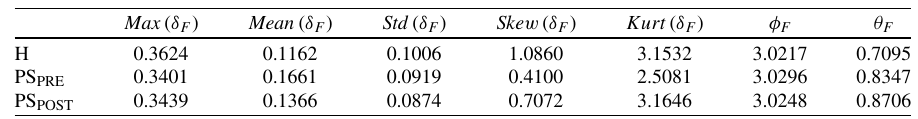
Fig. 15. Distance along straight line. Table 4 Parameters in Healthy (H), Post-stroke subjects before (PS PRE ) and after (PS POST ) the robot-aided rehabilitation, for direction S b (units column 1–3 and column 6–7: radians; column 4–5: adimensional)